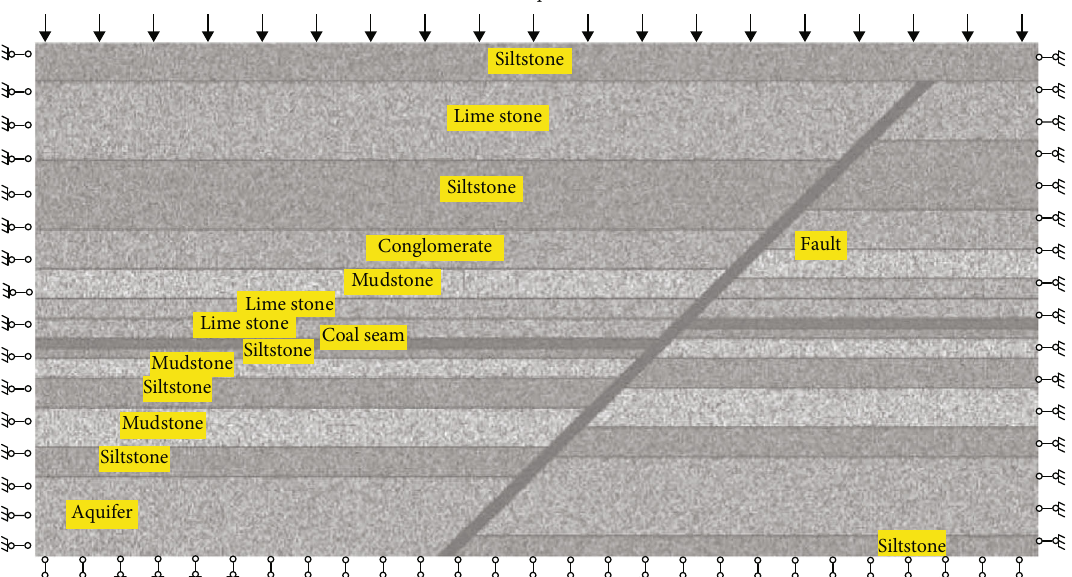
Figure 6: Numerical calculation model of deep mining with